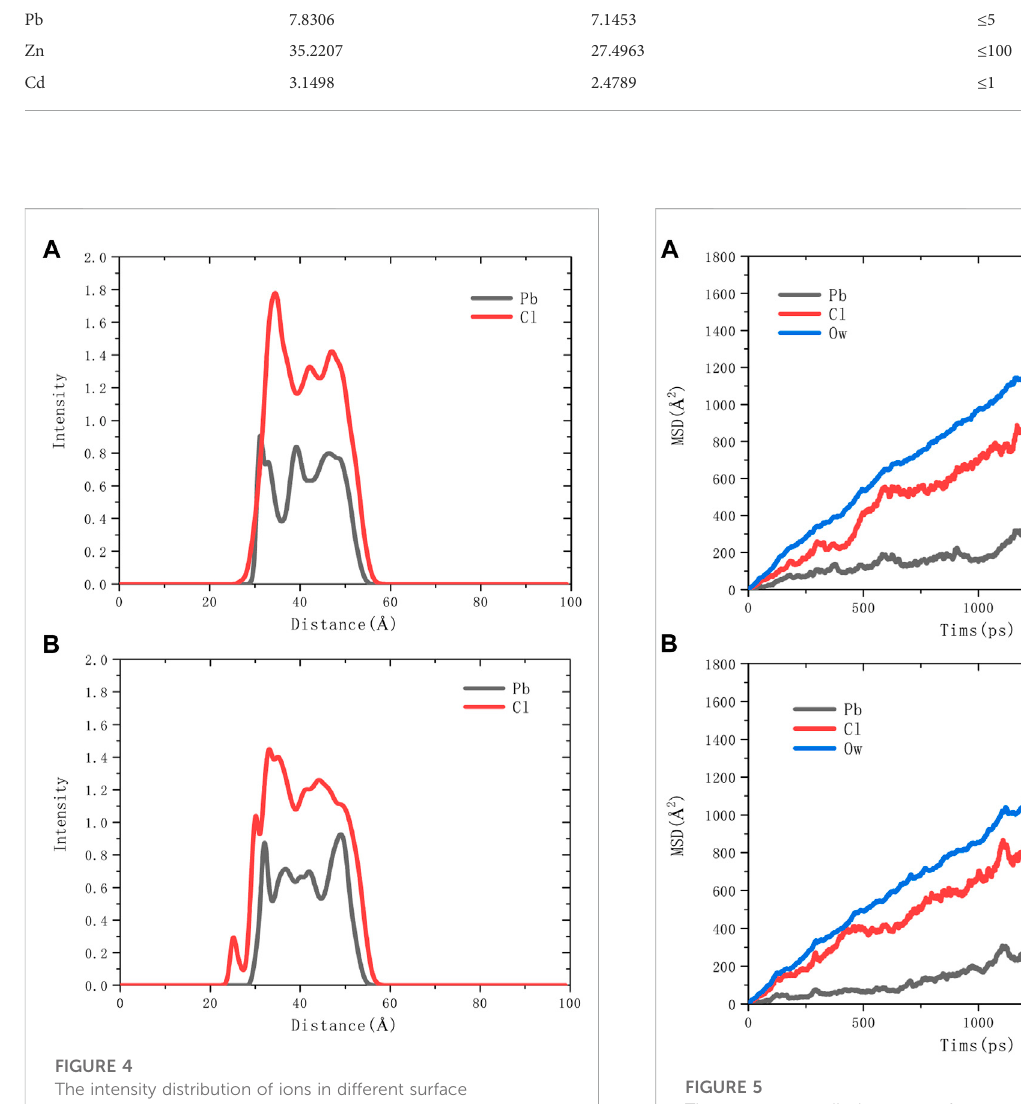
FIGURE 4 The intensity distribution of ions in different surface adsorption models: (A) C-S-H 1.7 (B) C-S-H 1.9.